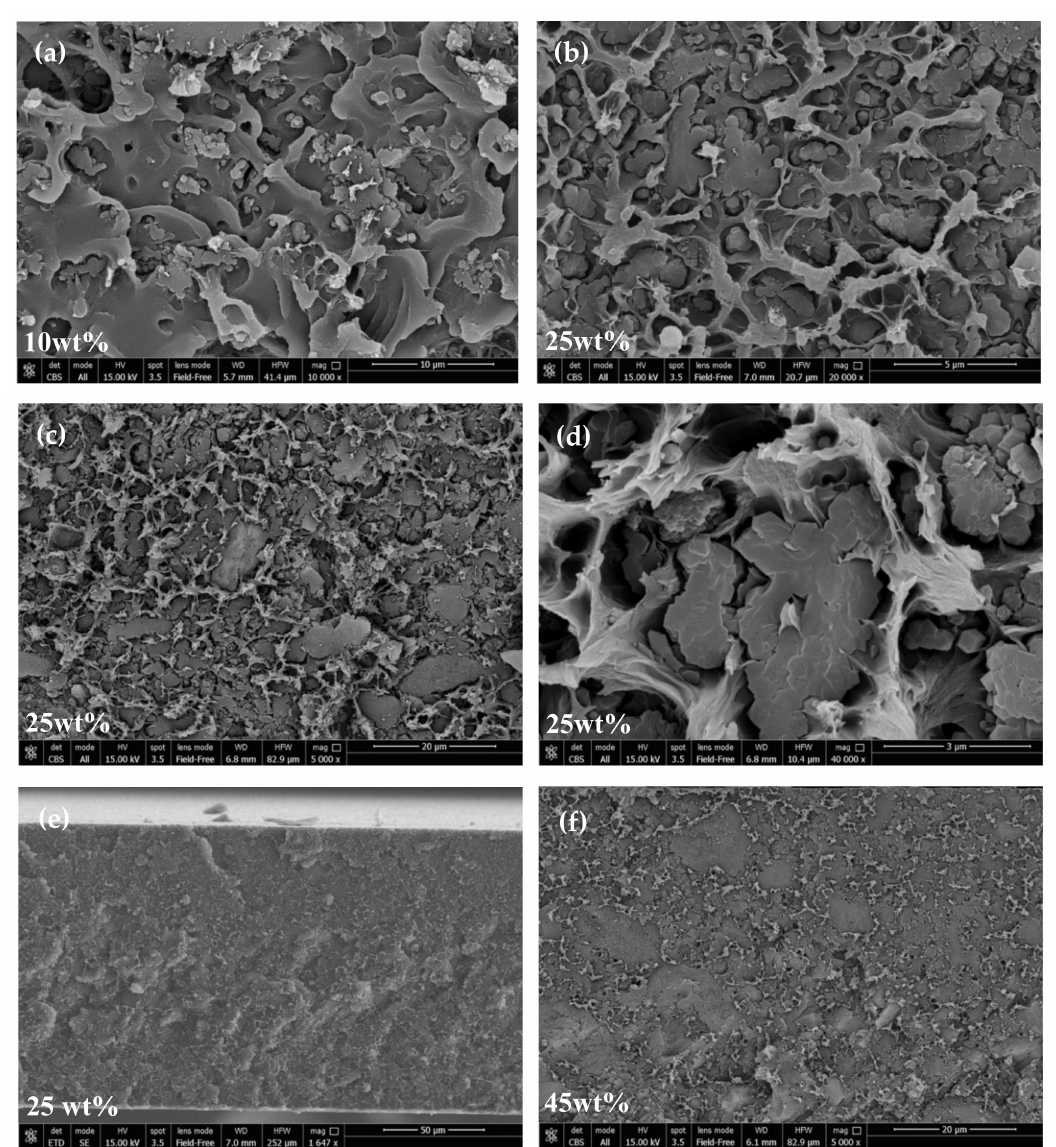
Figure 5. SEM images of the cross-section of ZIF-8 / PPO mixed-matrix membranes at di ff erent loadings and magnitudes: ( a ) 10 wt%, ( b – e ) 25 wt%, and ( f ) 45 wt%. Other images can be found in the Supplementary